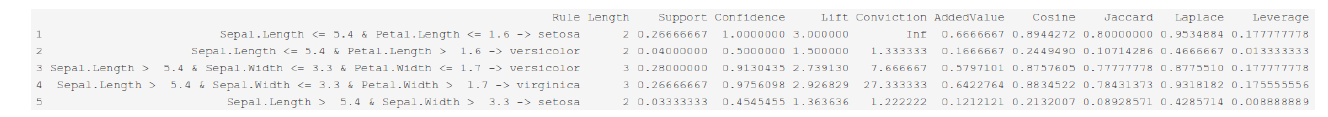
Figure 4. Decision rules generated from the final tree structure built from scratch.